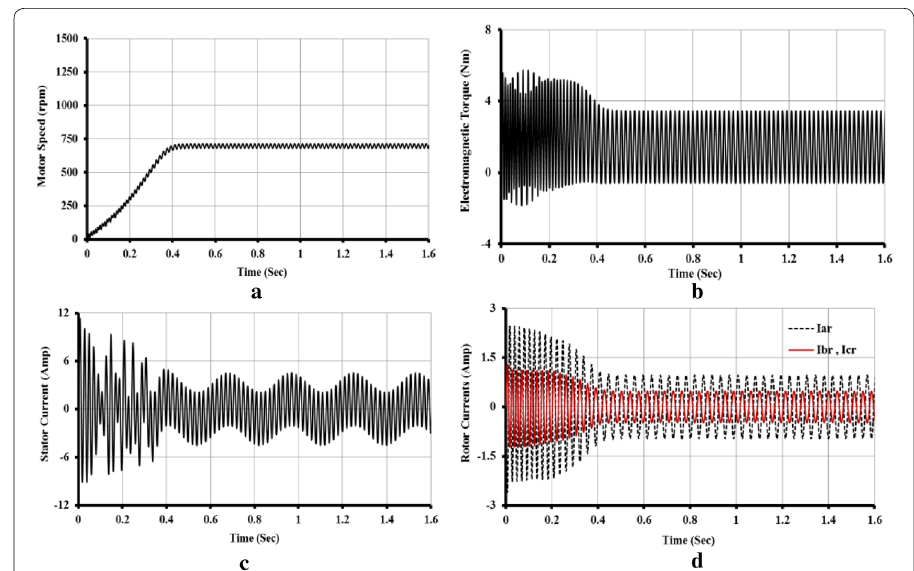
Fig. 4 Motor performance for standard delta with external open circuit rotor windings connection, a motor speed, b electromagnetic torque, c stator phase current and d rotor currents